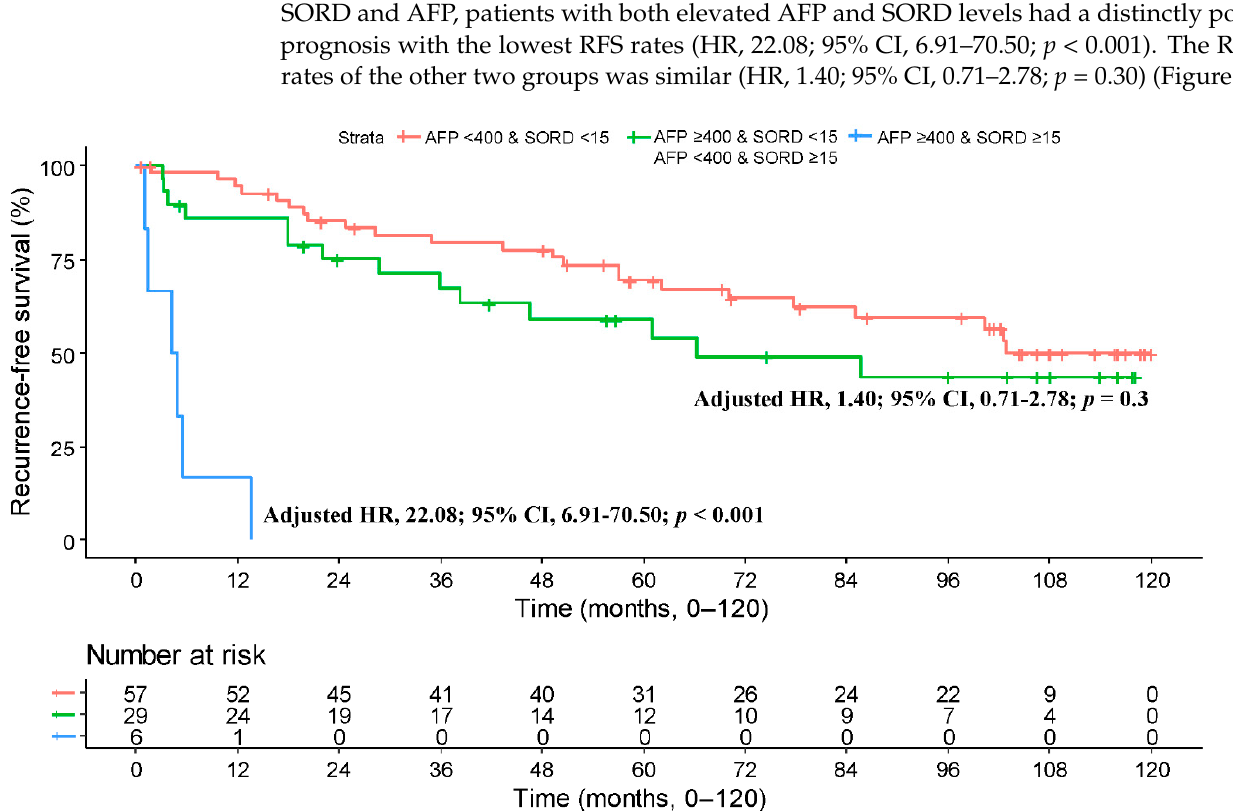
Figure 4. Kaplan–Meier plot for recurrence-free survival stratified by serum levels of AFP and SORD. Hazard ratio adjusted for sex and ICG R15.